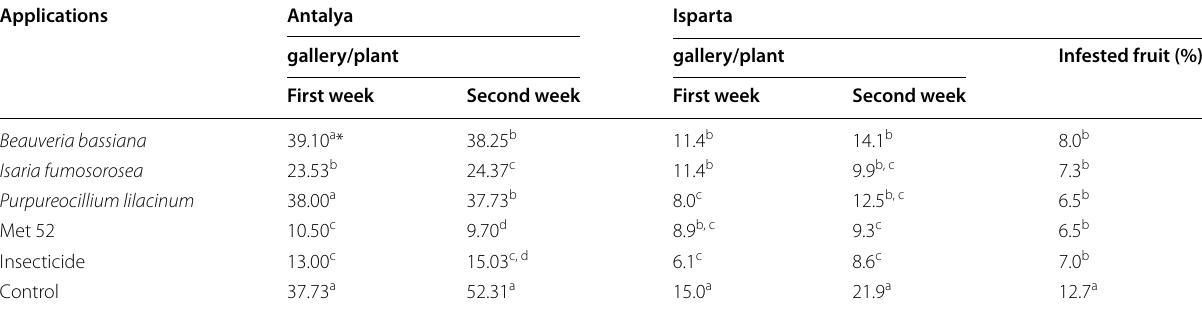
Table 4 Mean numbers of galleries on the tomato plants in the greenhouses in Antalya and Isparta, 1,2 weeks after applications of entomopathogens (gallery/plant) and mean rates of infested